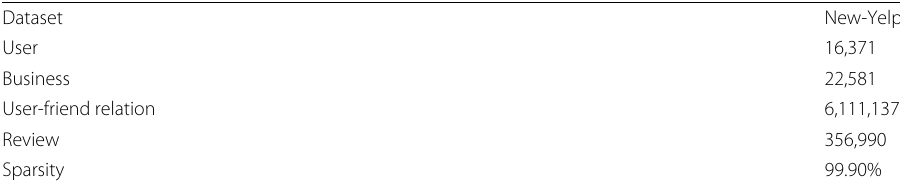
Table 1 Detailed statistics of